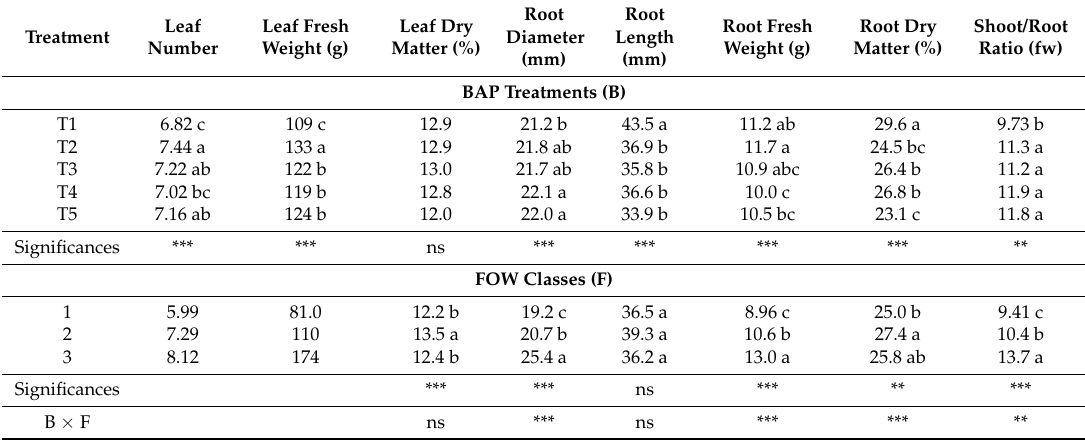
Table 5. Characterization of the harvested offshoots from field mother plants according to 6-benzylamino purine (BAP) treatments and to their size classes.